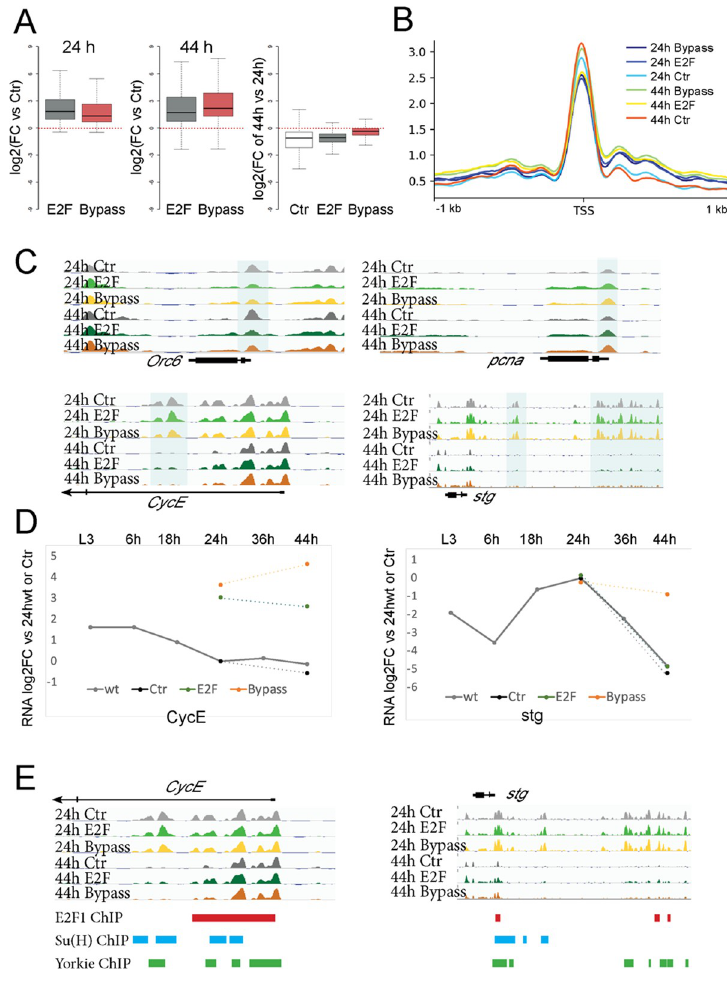
Fig 4. Distal enhancer accessibility of complex cell cycle genes is developmentally controlled and independent of cell cycling status. (A) Expression of cell cycle genes is increased when we delay or bypass cell cycle exit (log2 fold change for cell cycle genes versus ctrs expressing GFP). (B) Line plots of average FAIRE signal for cell cycle genes. Accessibility at most cell cycle genes’ TSS is slightly decreased when cell cycle exit is delayed (44 h E2F expression, p - value = 1.004 × 10 − 5 , Mann-Whitney U Test). (C) Regulatory elements for simple cell cycle genes ( orc6 , pcna ) remain accessible independent of cycling status. Complex cell cycle genes ( cycE , stg ) lose accessibility at regulatory regions independent of cycling status. (D) Expression of cycE and stg during metamorphosis (gray line, compared with 24-h wings) and genetic manipulations (colored dots, compared with 24-h ctr wings). stg possesses higher barrier for activation compared with CycE . Closed stg regulatory elements likely prevent stg expression in the late robust E2F- expressing wings, whereas E2F + CycD/Cdk4 can overcome this proliferation barrier. (E) Dynamic distal wing enhancers and TSS proximal regions for cycE and stg contain sites that bind E2F1, Su(H), and Yorkie based on ChIP in cycling tissues. The underlying data in Fig 4D can be found within S4 Data. Cdk, cyclin-dependent kinase; ctr, control; ChIP, chromatin immunoprecipitation; CycD, Cyclin D; CycE, Cyclin E; E2F, E2F transcription factor; FAIRE, formaldehyde-assisted isolation of regulatory elements; FC, fold change; GFP, green fluorescent protein; orc6, origin recognition complex subunit 6; pcna, proliferating cell nuclear antigen; stg, string; Su(H), Suppressor of Hairless; TSS, transcription start site; wt, wild type.